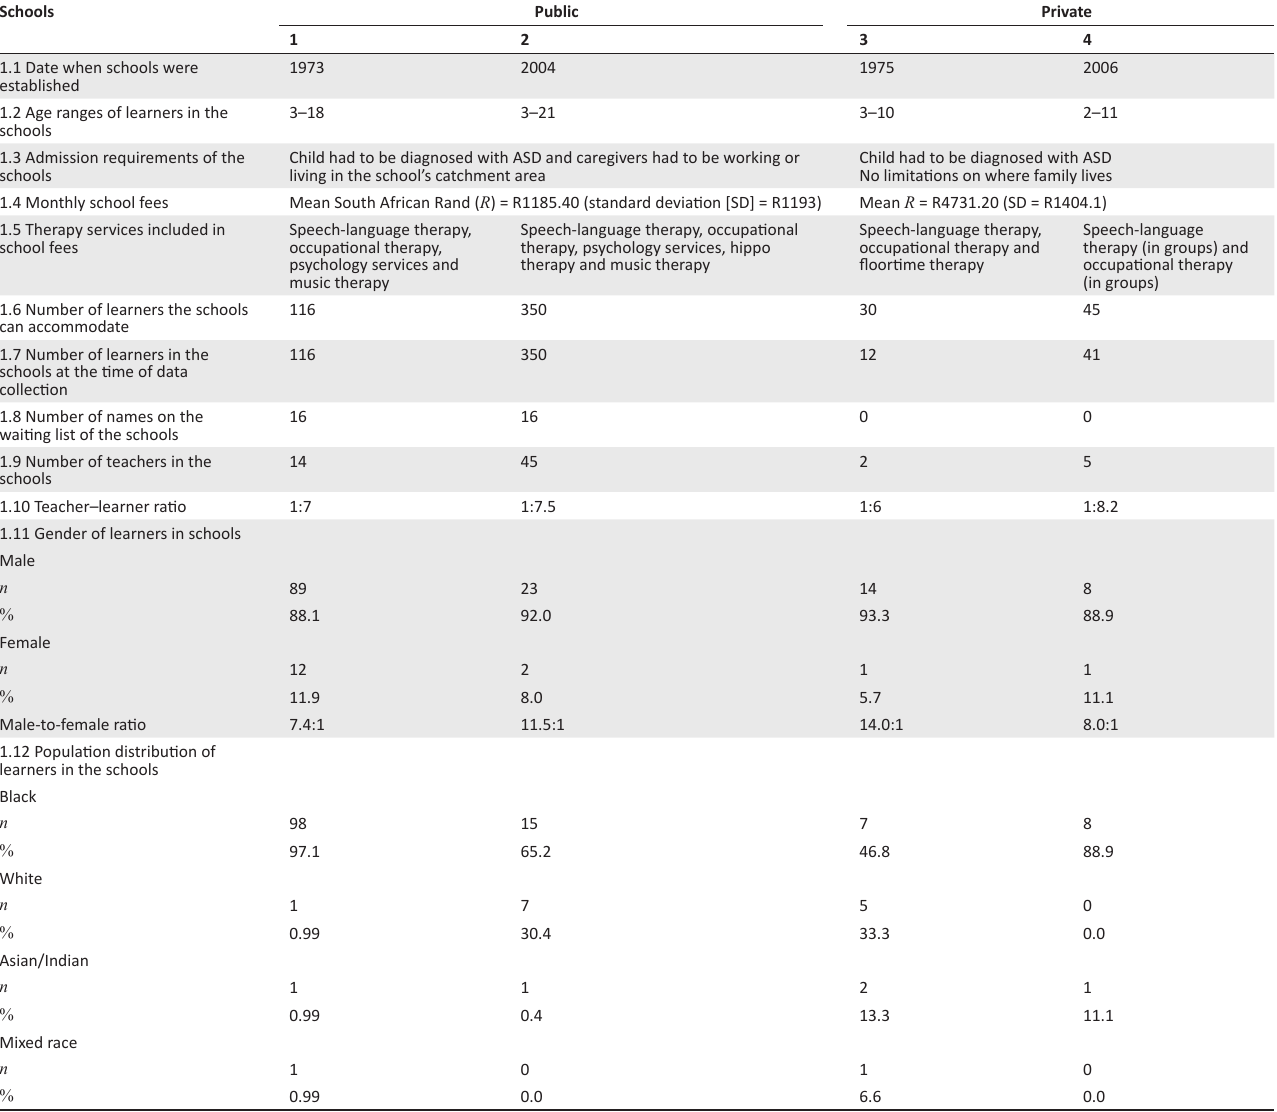
TABLE 1: Profiles of the participating autism-specific schools.